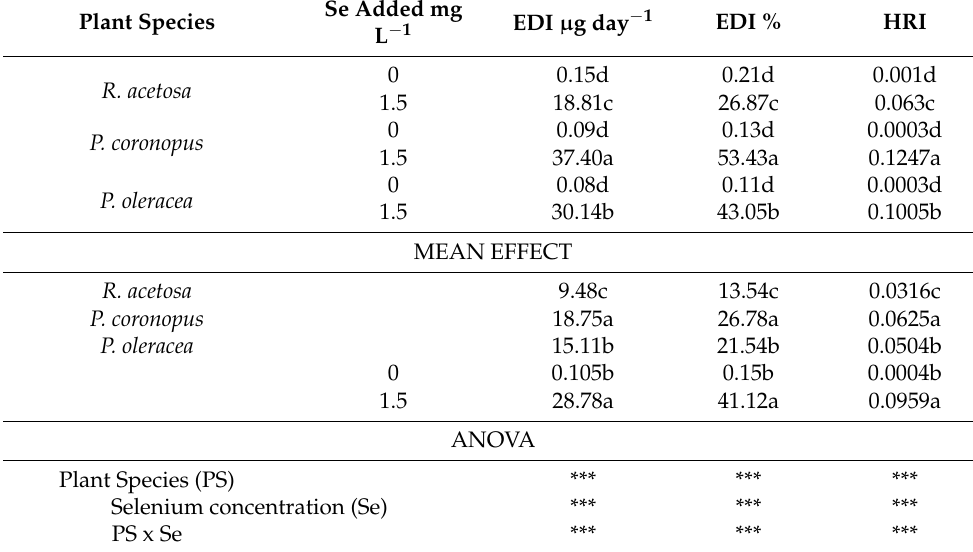
Means (n = 3) flanked by the same letter are not statistically different for p = 0.05 after Duncan’s test. Significance level: *** p ≤